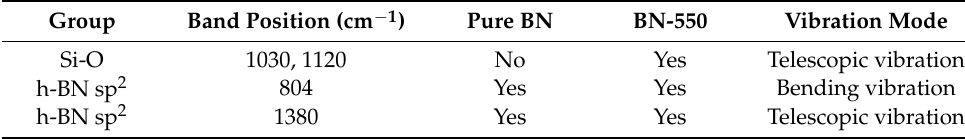
Figure 3. FT-IR spectra of pure BN and BN-550. Table 1. Group and band position of BN infrared spectrum.